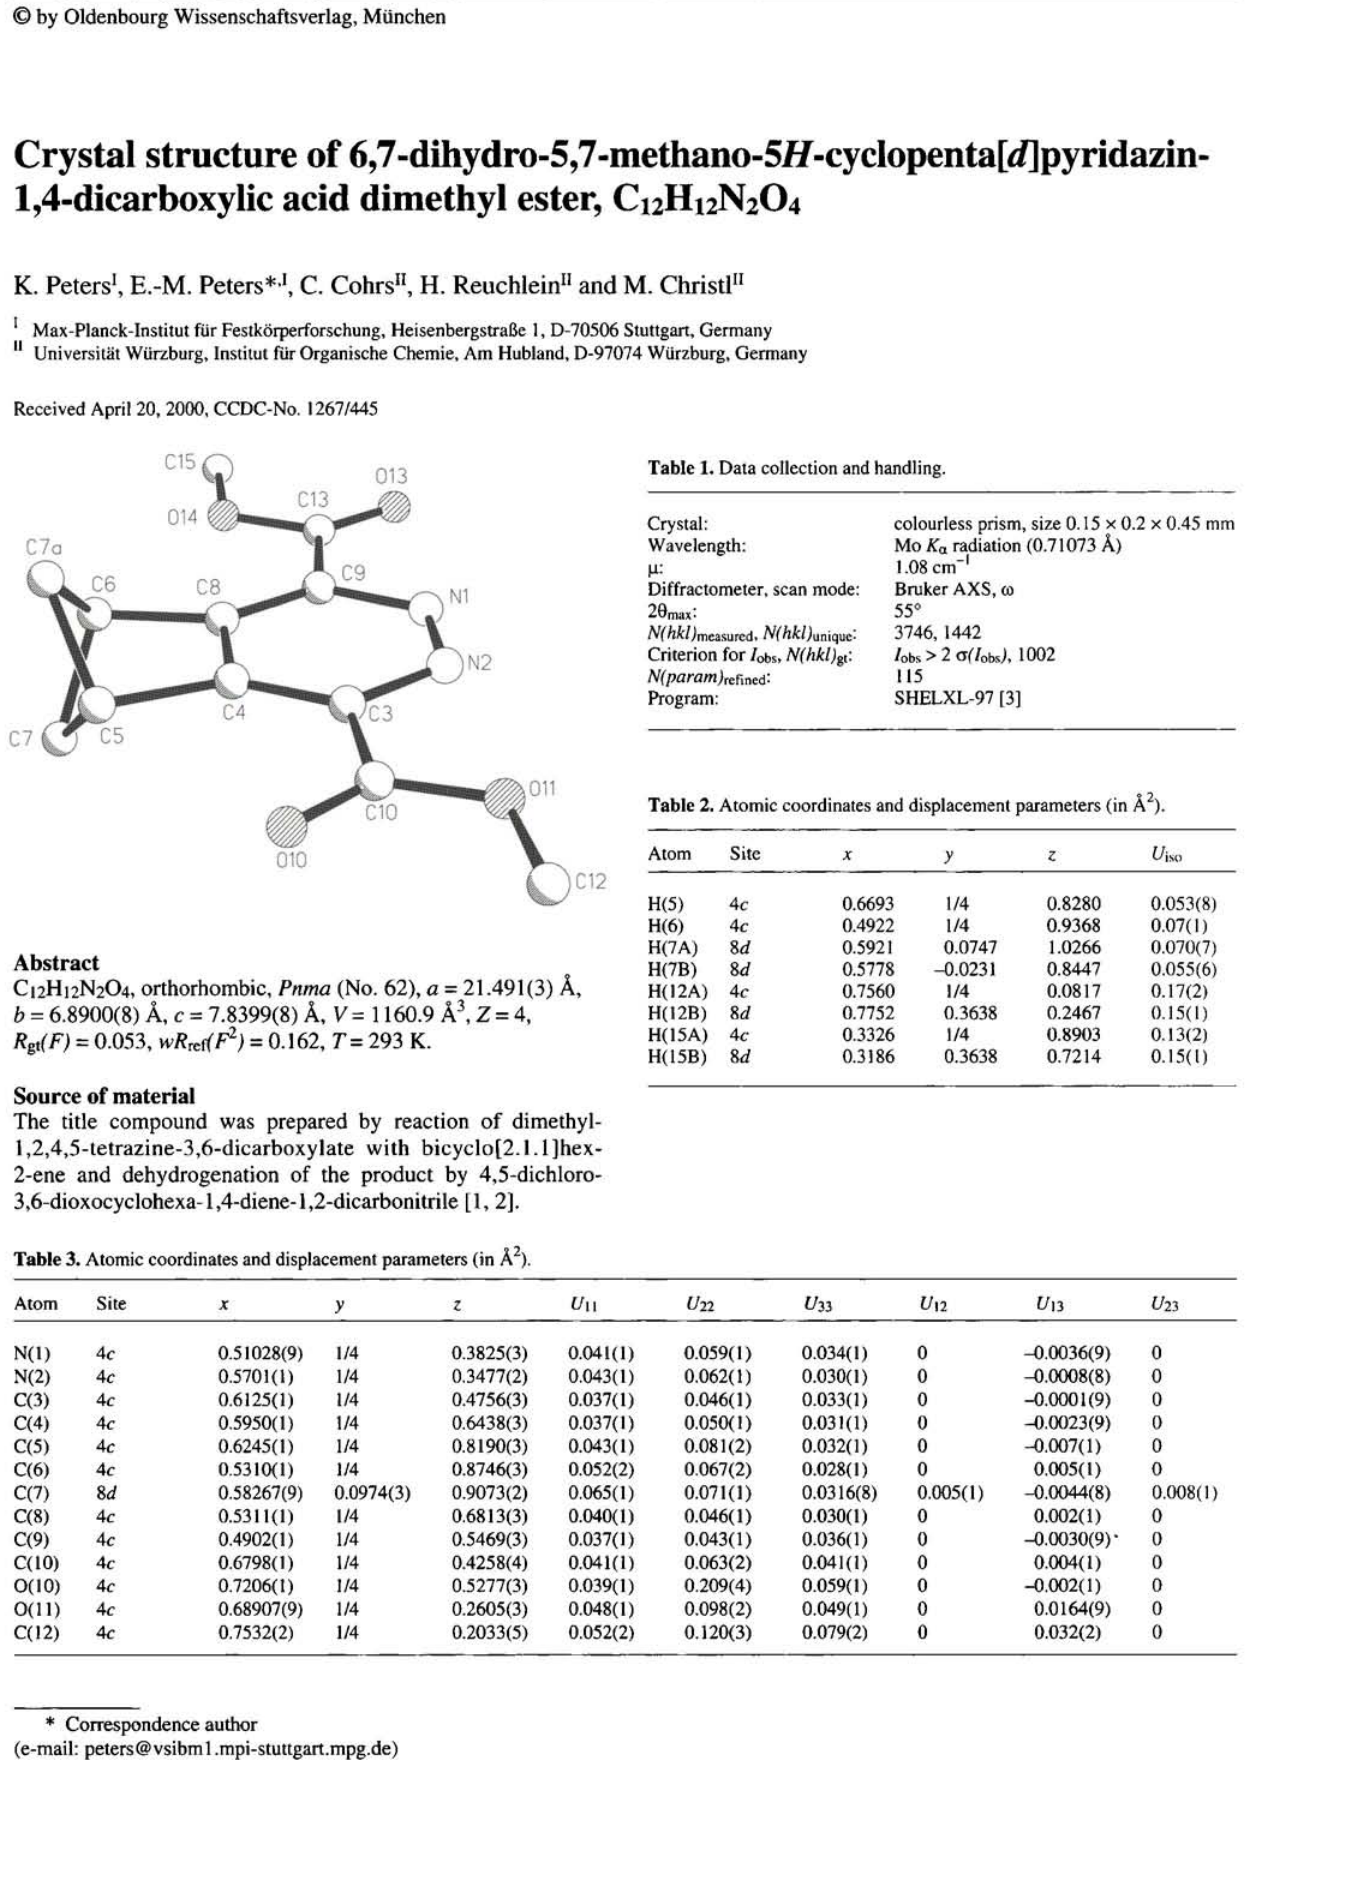
Table 3. Atomic coordinates and displacement parameters (in A 2 ).